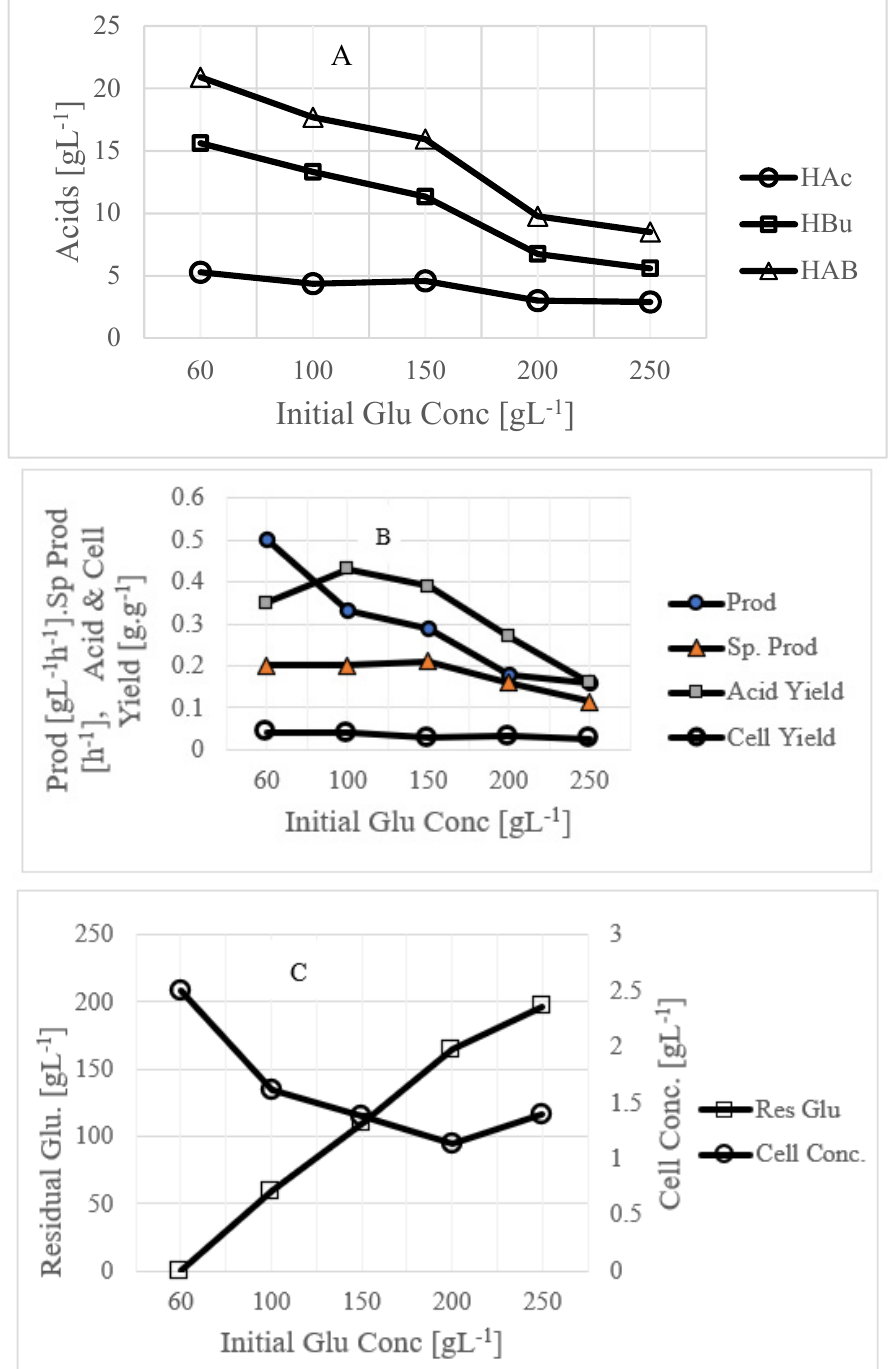
Figure 1. Glucose inhibition on C. tyrobutyricum . ( A ) Production of acids at various glucose concen- trations; ( B ) productivities, specific productivities, acid yield, and cell yield; ( C ) residual glucose and cell concentration. HAc—acetic acid; HBu—butyric acid; HAB—total acetic and butyric acids; Prod— productivity; Sp. Prod—specific productivity; Res Glu—residual glucose; cell conc—cell